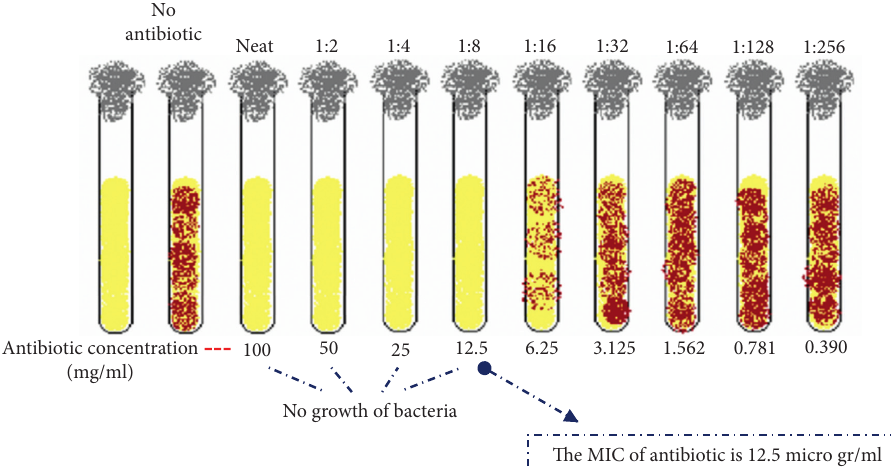
Figure 2: Schematic diagram of the method.